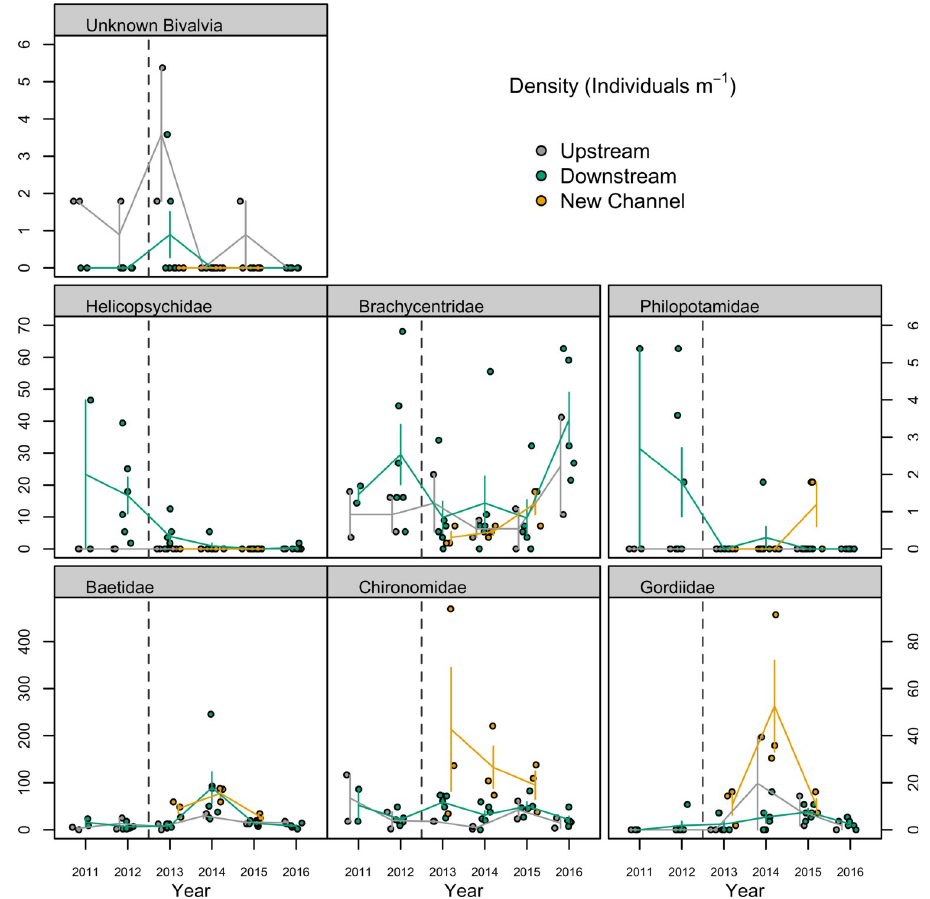
Fig 4. Selected macroinvertebrate taxa whose abundances were sensitive to position above or below dam, timing of dam removal (dashed vertical line), or development of new channel sites following reconstruction of Boardman River channel following dam removal. Abundance data from 2011–2016, Boardman River, Michigan (USA). Taxa grouped by conditions indicated. Top row: Bivalvia (unknown taxa at more specific levels) were Upstream indicators. Middle row: Helicopsychidae, Philopotamidae, and Brachycentridae were taxa indicative of Downstream-before sites compared to both Upstream and Downstream-after sites, potentially representing groups most affected by dam removal. Bottom row: Baetidae, Chironomidae, and Gordiidae were taxa indicative of sites in New Channel areas. Points show observed abundances. Vertical lines indicate mean +/- SE. Right-hand Y axis scale applies to third (last) group in second and third rows. Site groupings are offset on the X-axis for